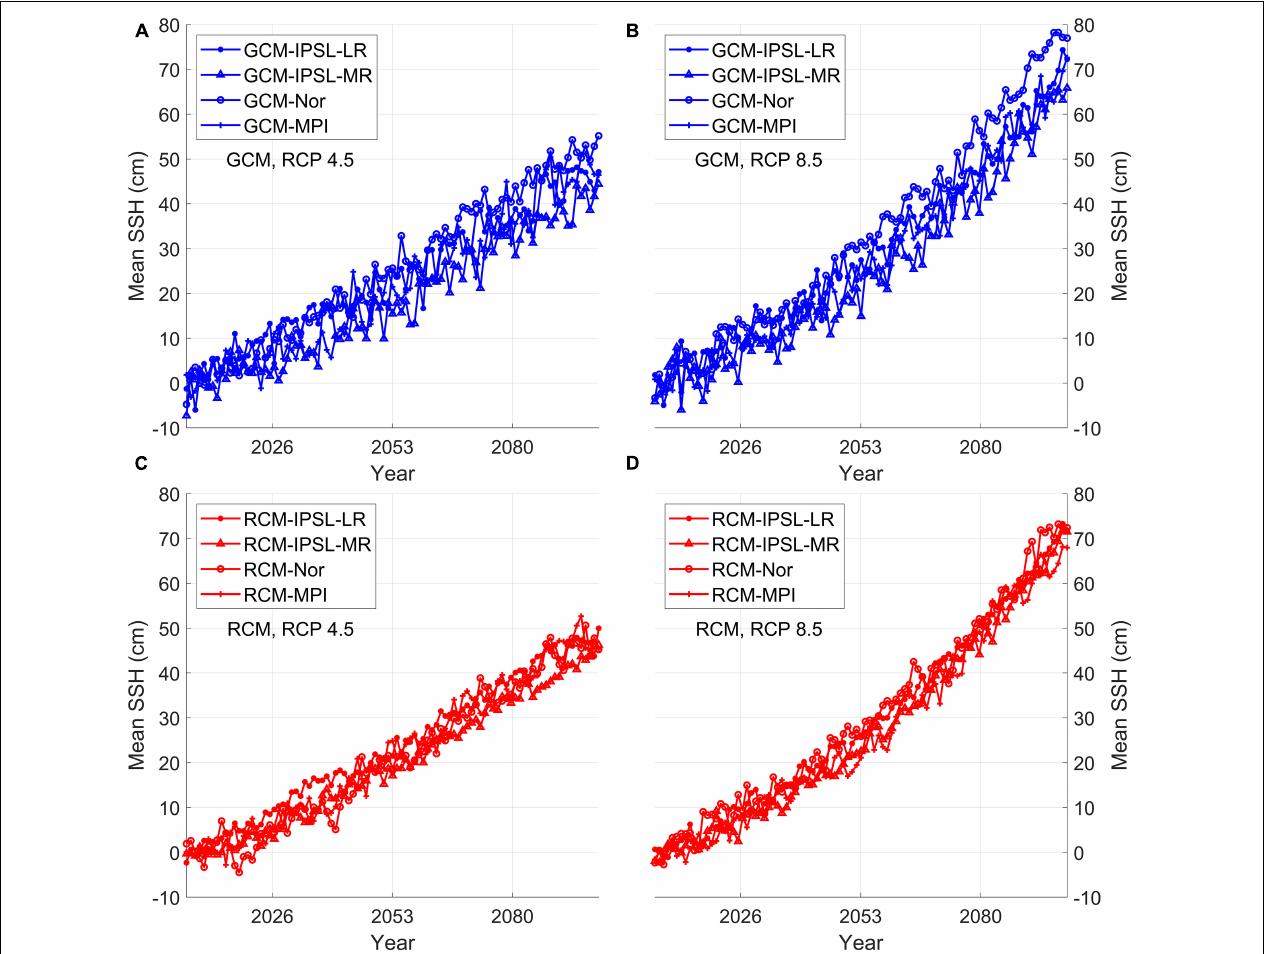
FIGURE 8 | Timeseries of sea-level changes (unit: cm) from 2006 to 2100, for two representative concentration pathway (RCP) scenarios: (A) GCMs—RCP 4.5, (B) GCMs—RCP 8.5, (C) RCMs—RCP 4.5, and (D) RCMs—RCP